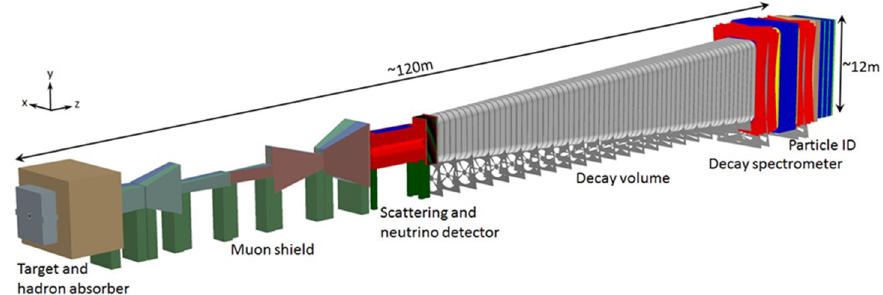
Figure 1. Overview of the SHiP experiment.